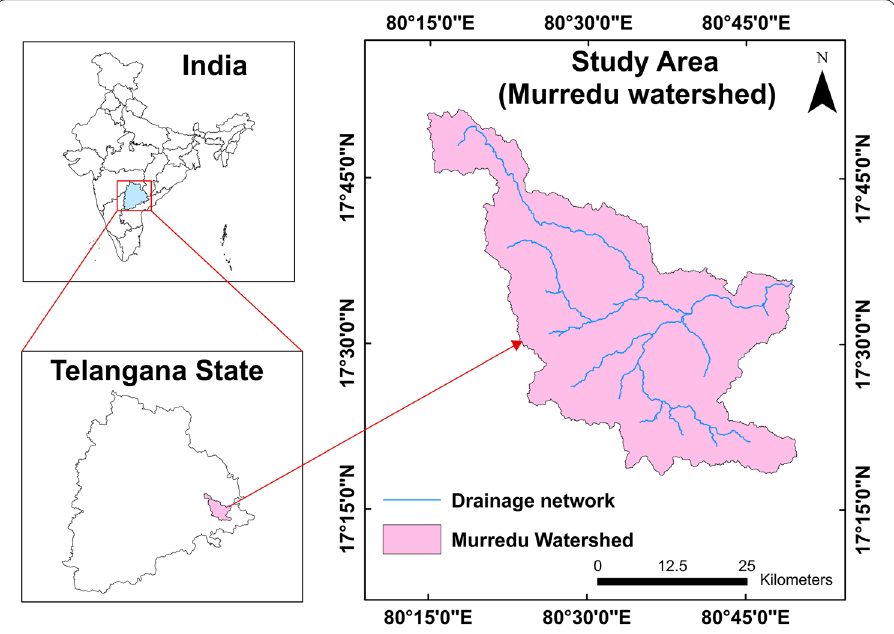
Fig. 1 Geographical map of the Murredu River